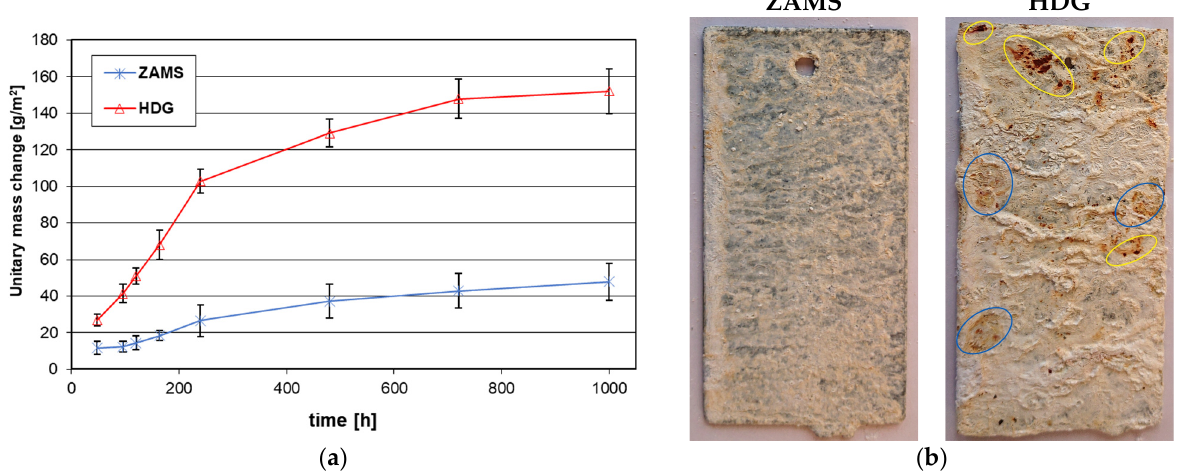
Figure 6. Results of the NSS test: ( a ) development of unit mass change of coatings and ( b ) surface appearance of coatings after the 1000 h NSS test.